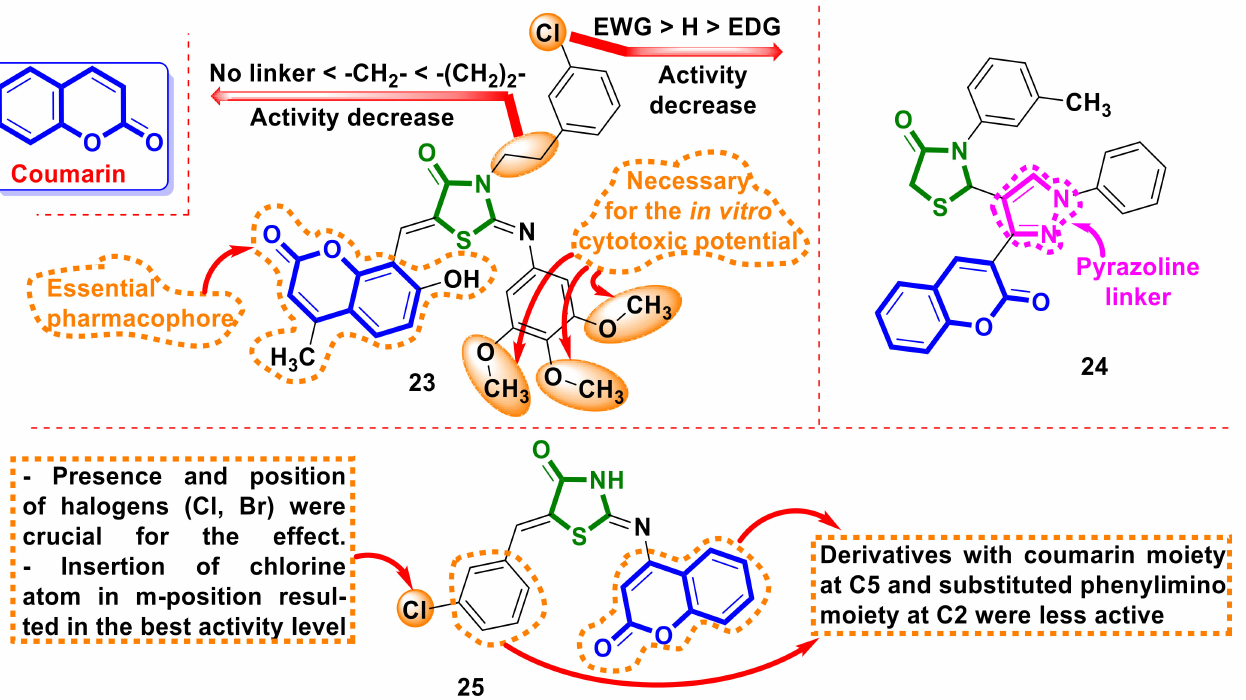
Figure 10. Structures of 4-thiazolidinone hybrids with coumarin motifs in the molecules and empirical SAR